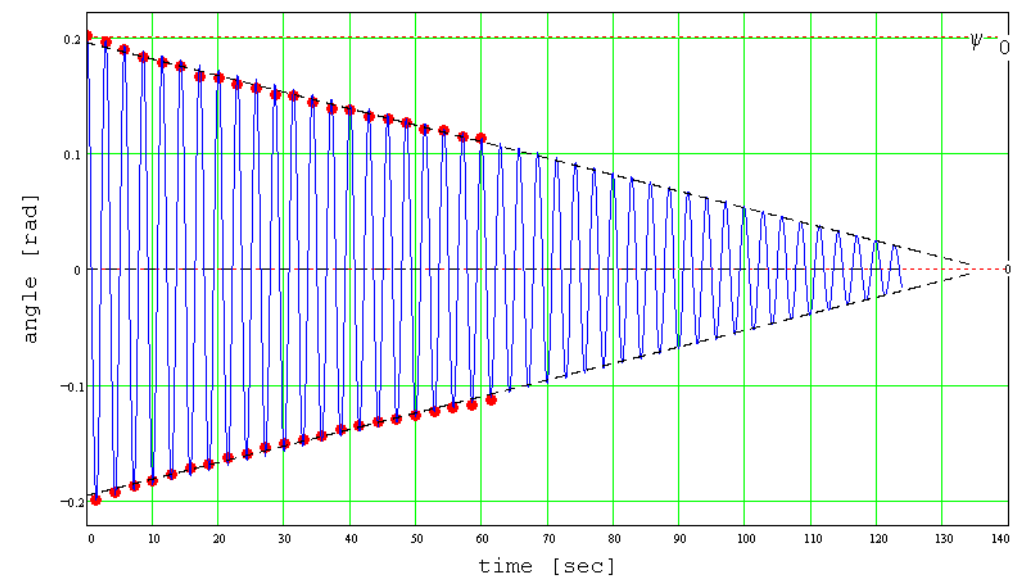
Figure 15. Theoretical angular elongation and values of experimental angular amplitude.